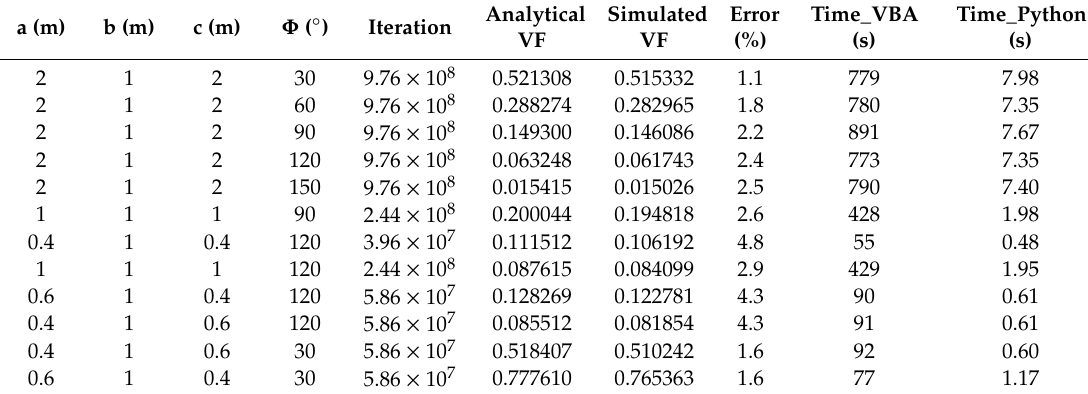
Table A2. View factor simulation data for element size h i = 0.008 m.